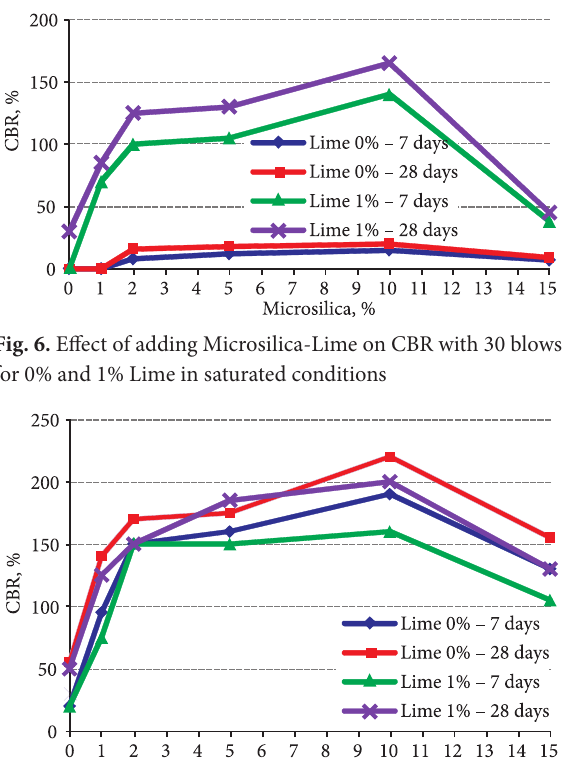
Fig. 5. Effect of adding Microsilica-Lime on CBR with 30 blows for 3% and 5% Lime in dry conditions